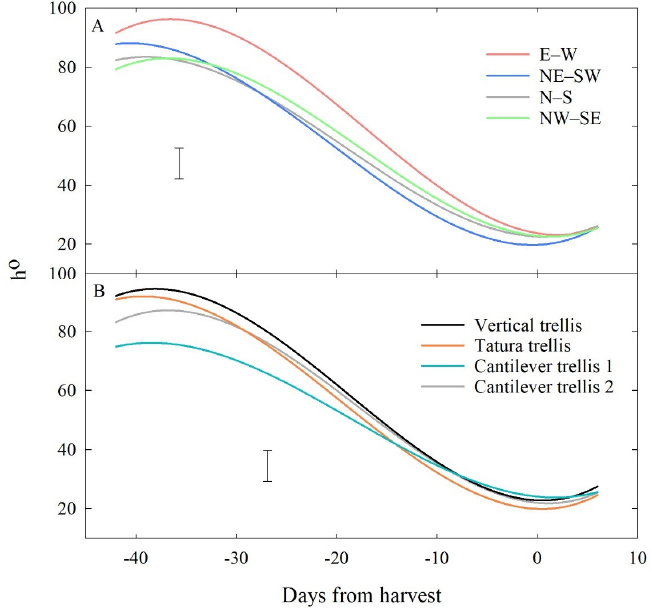
Figure 6. Cubic models of skin hue angle (h°) against time ( n days from harvest) in ‘Majestic Pearl’ nectarine fruit subjected to different row orientations ( A ) and training systems ( B ). Significant differences are shown with Fisher’s Least Significant Difference (LSD, 5%) bars.